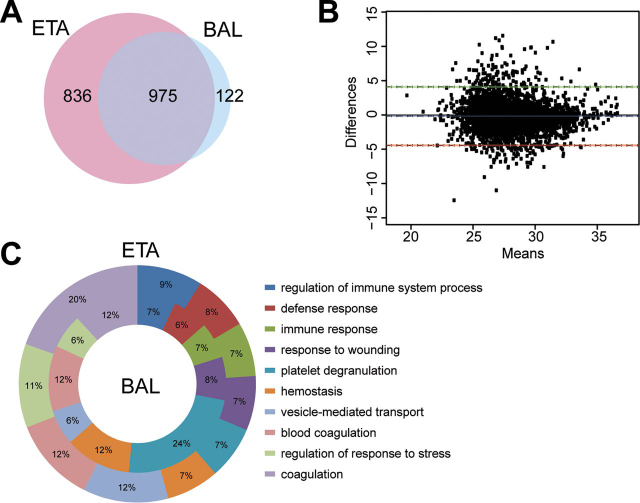
Comparison of ETA and BAL proteomes in VAP patients.A, The Venn diagram shows the numbers of proteins shared between ETA and BAL proteins. B, Bland-Altman analysis of bias and 95% limit of agreement for ETA versus BAL proteins. C, Gene ontology (GO) analysis (biological process) of ETA and BAL proteins. donut plot shows the top 10 enriched GO terms of biological process for BAL (inner core) and ETA (outer core) proteins.